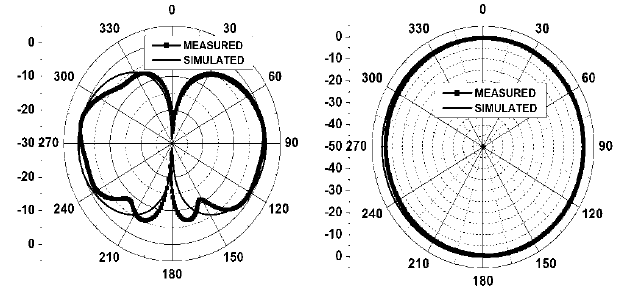
Figure 10: Comparison of measured and simulated